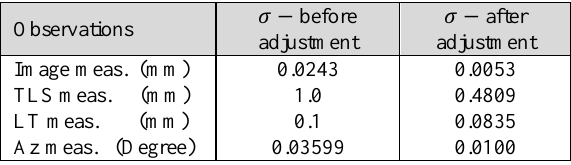
Table 3. Standard deviations of the observations